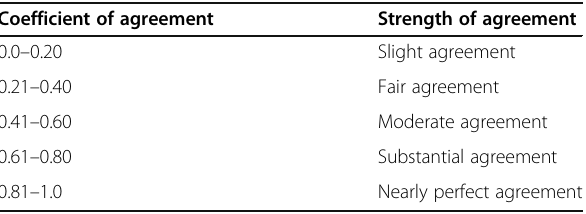
Table 1 Agreement for ordinal variables was examined using the weighted kappa coefficient. The agreement coefficients are interpreted as